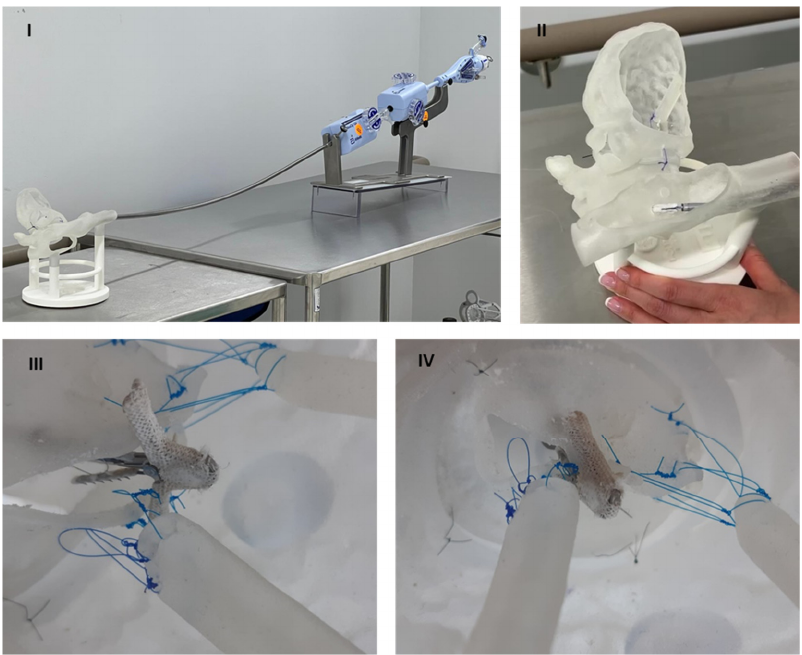
Figure 6. Report of the steps of the MitraClip simulator testing procedure. ( I ): Preparation. ( II ): Guide insertion. ( III ): Positioning of the clip. ( IV ) Implantation.